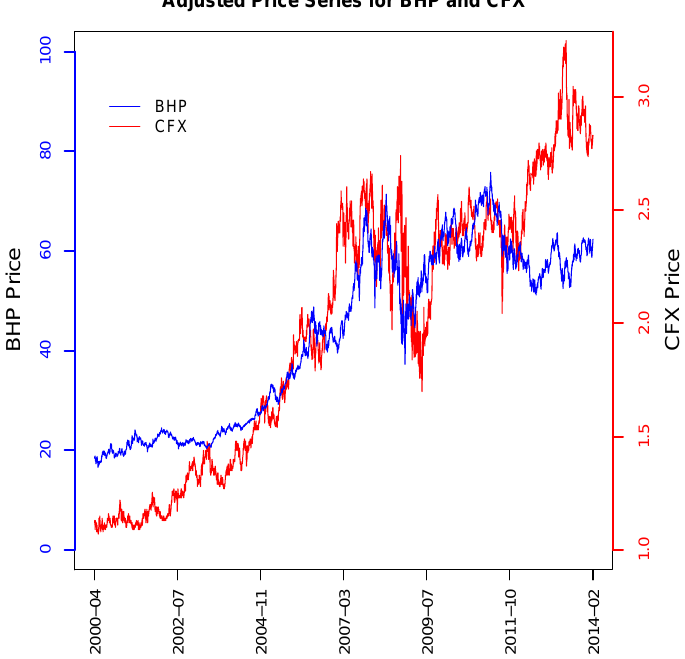
Figure 4. Time series plot of two stocks identified in the scatter plot of components 151 and 152: BHP-Billiton (BHP) in basic materials and CFS Retail Property Trust Group (CFX) in the real estate